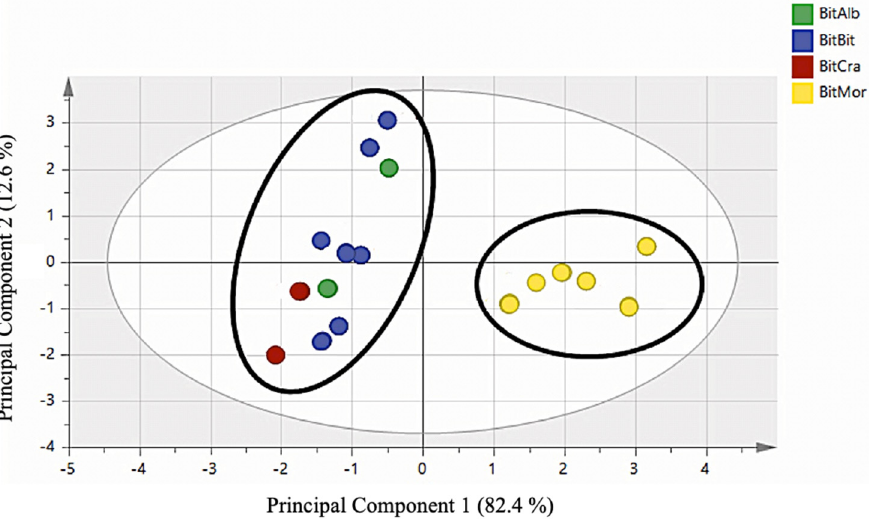
Figure 3. Score plot of PCA statistical analysis of B. morisiana and B. bituminosa varieties. Principal components 1 and 2 represented 95.0% of the variance.